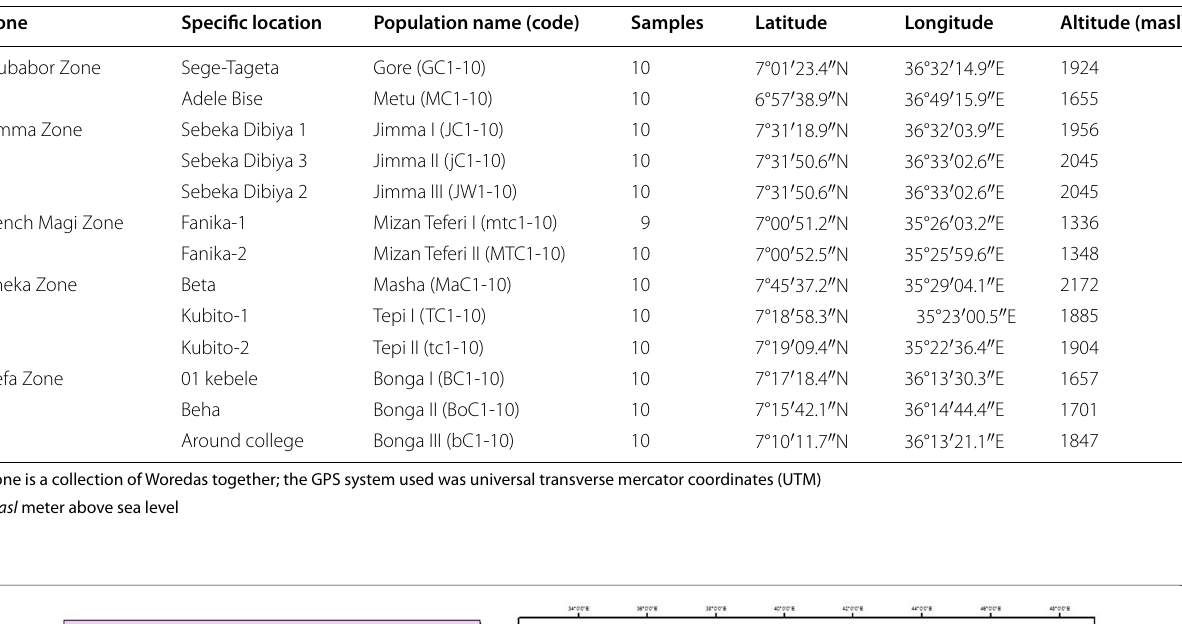
Table 1 Description of A. corrorima samples collected from different sites in Ethiopia